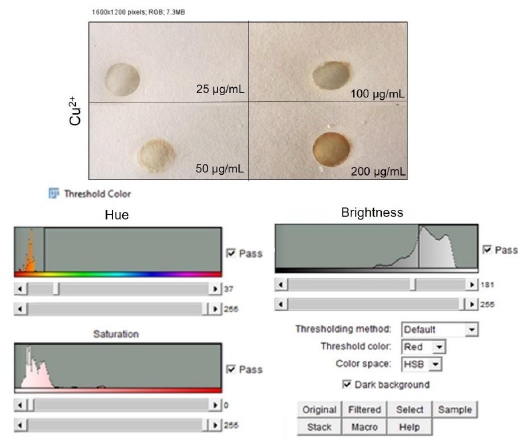
Figure 8. Top: Image acquisition of PAD after CuSO 4 .5H 2 O deposition at different concentrations. Down: threshold analysis, saturation and brightness adjustment by ImageJ software.